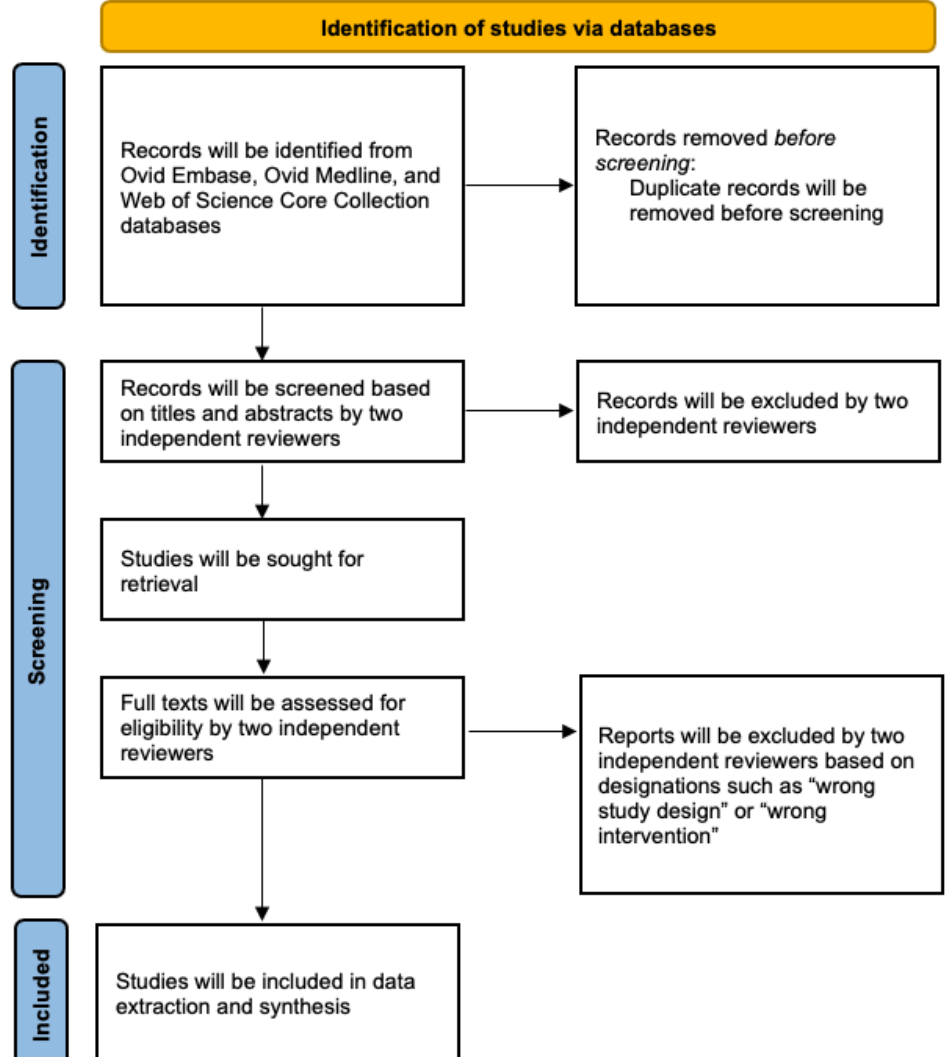
Figure 1. Flow diagram outlining the study search and